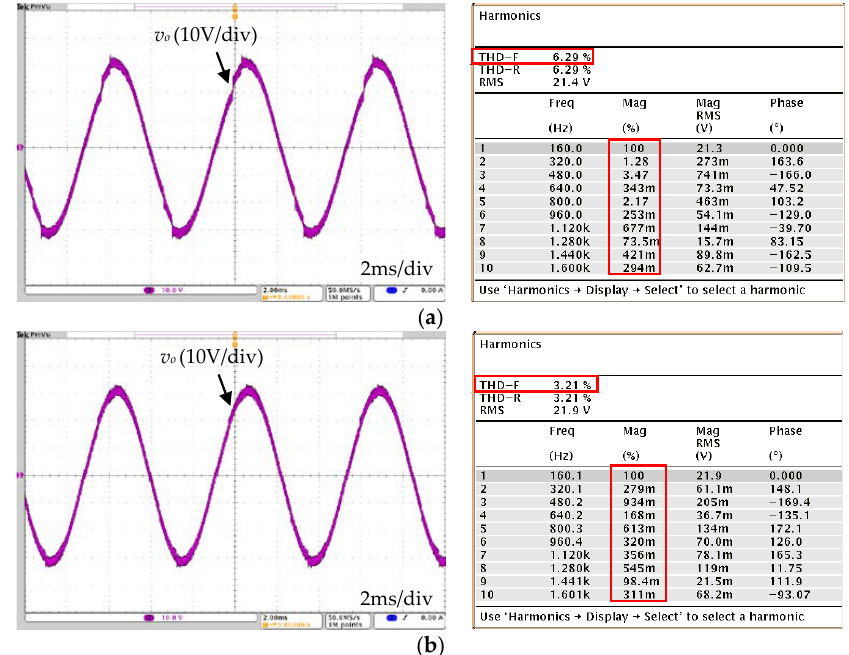
Figure 12. The current waveforms and their harmonic analysis results: ( a ) conventional control and ( b ) proposed control.